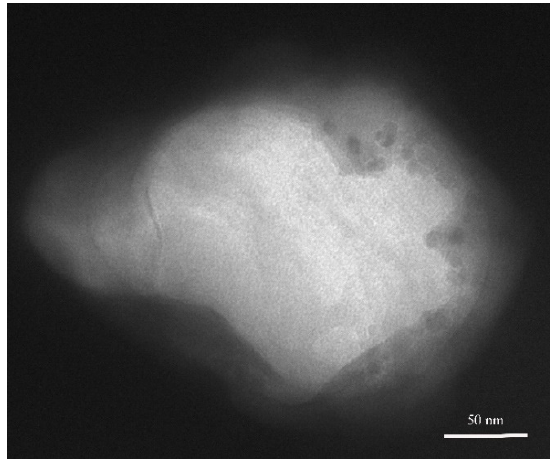
Figure 9. TEM image of liposome after neutron irradiation.